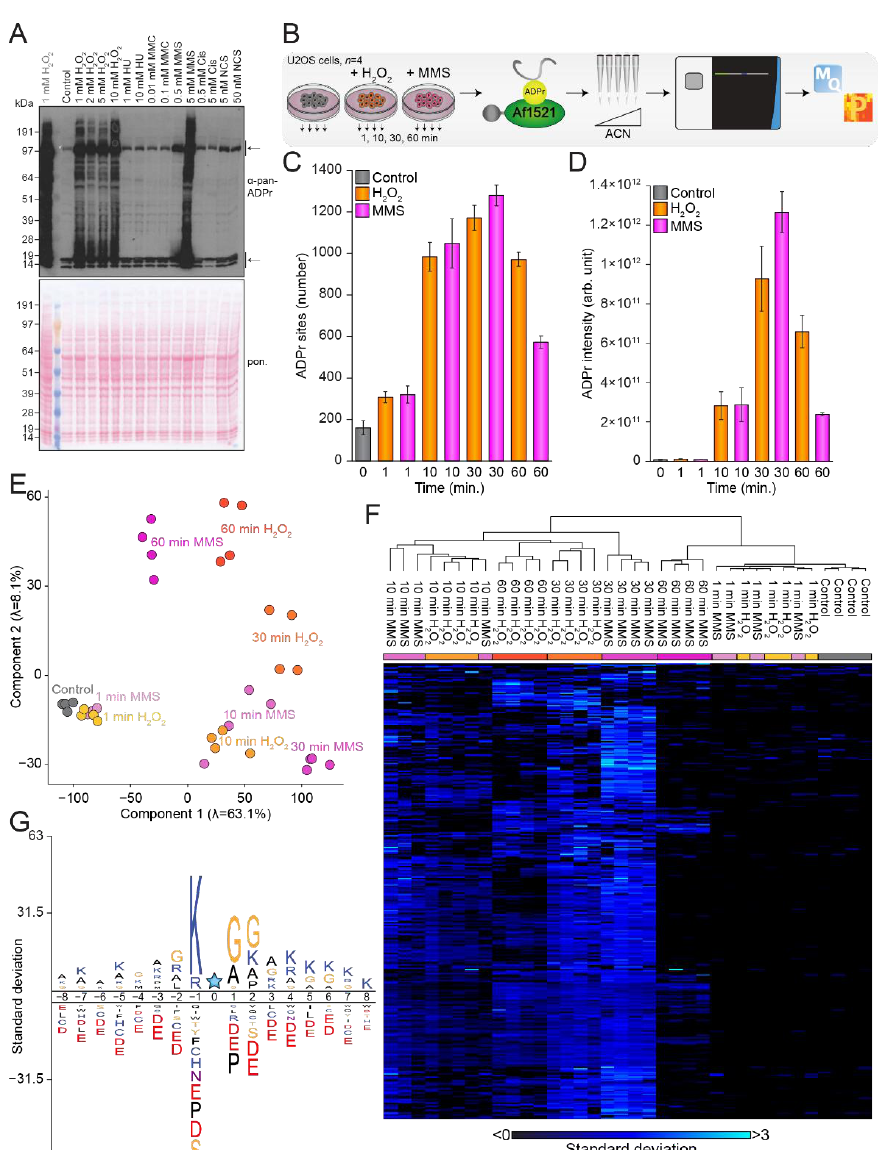
Figure 1. Induction of the ADPr signaling response. ( A ) Immunoblot analysis illustrating the ADPr equilibrium upon treatment with various concentrations of hydrogen peroxide (H 2 O 2 ), hydroxyurea (HU), mitomycin C (MMC), methyl methanesulfonate (MMS), cisplatin (Cis), and neocarzinostatin (NCS) in U2OS cells. The top arrow indicates auto-modified PARP1, and the bottom arrow indicates histone ADPr. The left lane (grey text) corresponds to lane 2 in Supplementary Figure S1A. ( B ) Overview of the experimental design. U2OS cells were left untreated or treated with 5 mM H 2 O 2 or 5 mM MMS for 1, 10, 30, or 60 min in quadruplicate, followed by enrichment of ADPr-modified peptides using the Af1521 macrodomain. Samples were fractionated at high pH, analyzed on the Fusion Lumos mass spectrometer, and processed using MaxQuant. ( C ) Histogram showing the number of ADPr sites identified. With n = 4 cell culture replicates, data are presented as mean values +/− standard deviations. ( D ) As C but showing the ADPr intensity. With n = 4 cell culture replicates, data are presented as mean values +/− standard errors of the mean. ( E ) Principal component analysis indicating the highest degree of variance. ( F ) Hierarchical clustering analysis based on z-scored log 2 -transformed suADPr site intensities. ( G ) The iceLogo analysis showing the sequence context surrounding identified serine ADPr sites (blue star), with amino acid residues above the line being enriched ( p < 0.01). Sequence windows from all serine residues in ADPr target proteins were used as a